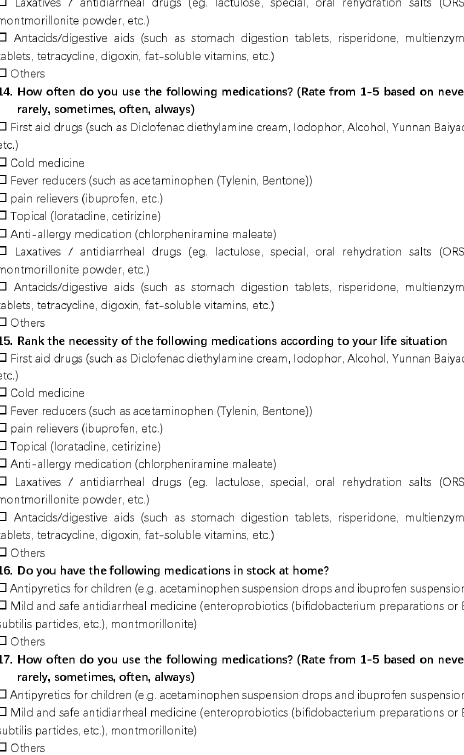
Figure 2. The detail of the questionnaire.